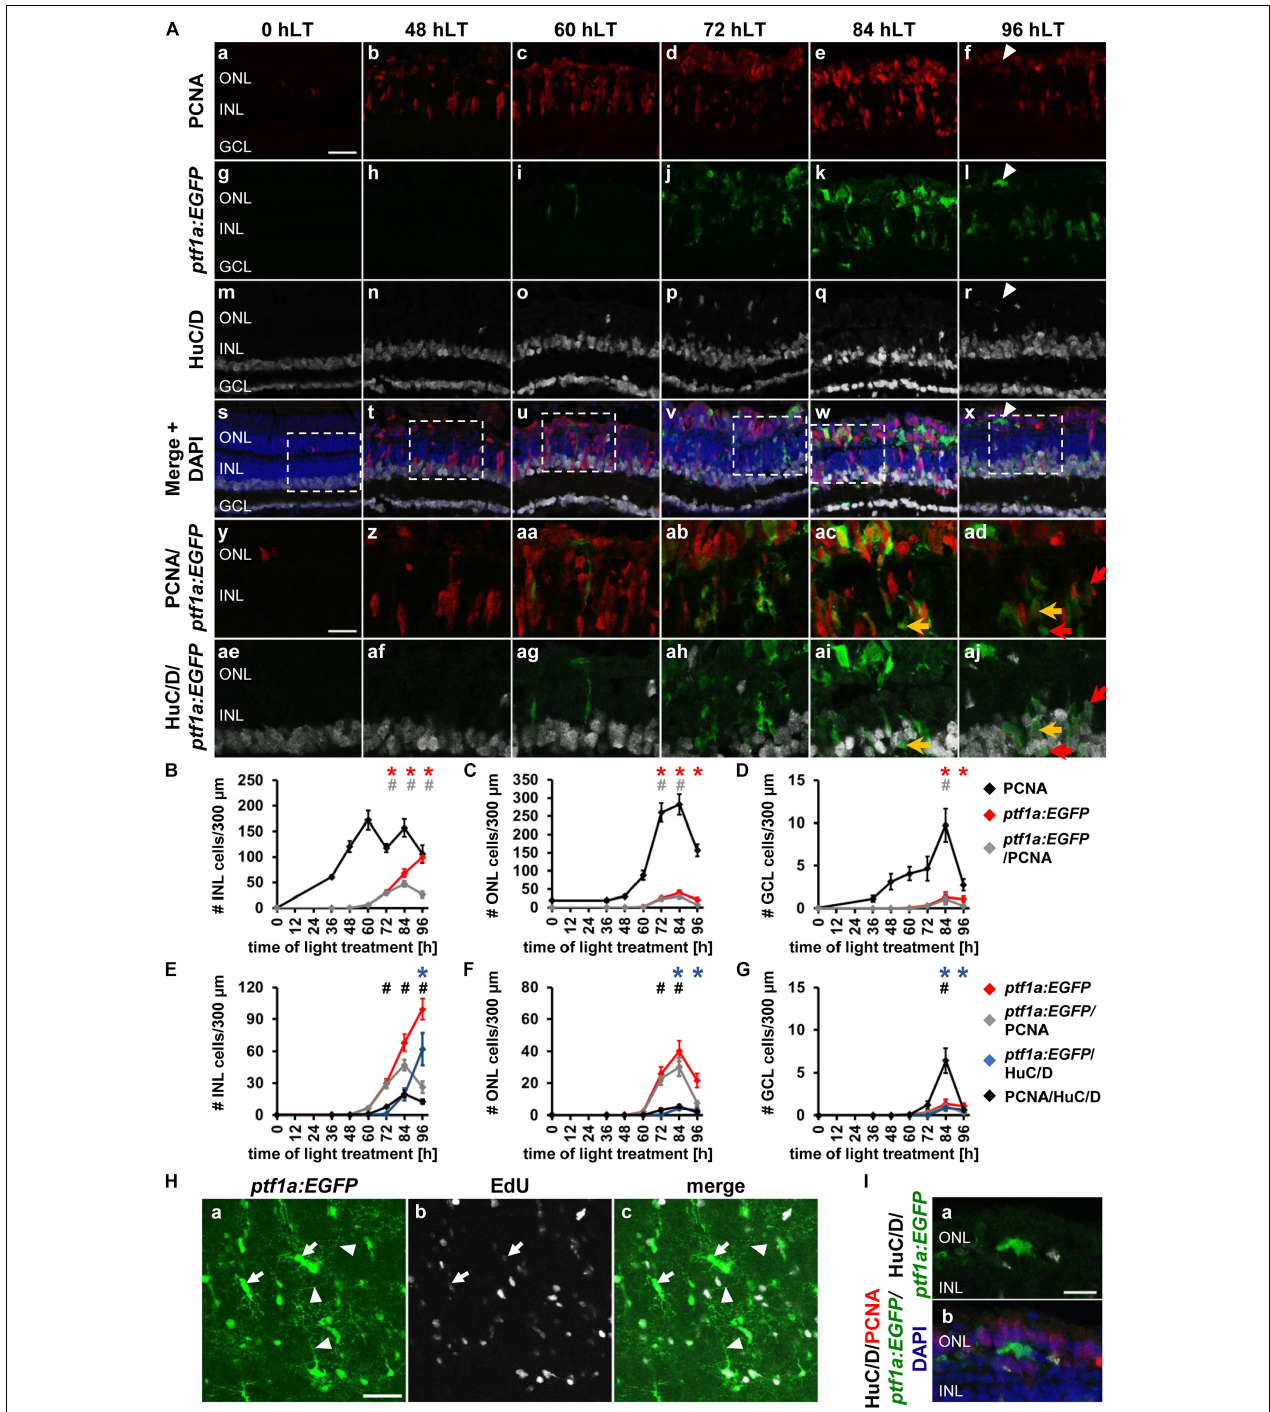
FIGURE 4 | Amacrine and horizontal cell competence factor ptf1a is upregulated in the light-damaged retina. (Aa–aj) Single z -plane confocal images of retinal sections from light-damaged Tg[ptf1a:EGFP]jh1 zebrafish (0, 48, 60, 72, 84, 96 hLT) immunolabeled for PCNA (Aa–f,As–ad) , GFP (Ag–l,As–aj), HuC/D (Am–x,Aae–aj) and counterstained with DAPI (As–x) . (Ay–aj) Regions outlined in panels (As–x) at higher magnification. Arrowhead, ptf1a:EGFP -positive ONL cell with an elongated morphology. Yellow arrows, ptf1a:EGFP , PCNA and HuC/D-triple positive cell. Red arrows, ptf1a:EGFP and HuC/D-double positive cell that is PCNA-negative. (B–D) Number of PCNA-positive, ptf1a:EGFP -positive and PCNA and ptf1a:EGFP -double positive cells in the INL (B) , ONL (C) , and GCL (D) over